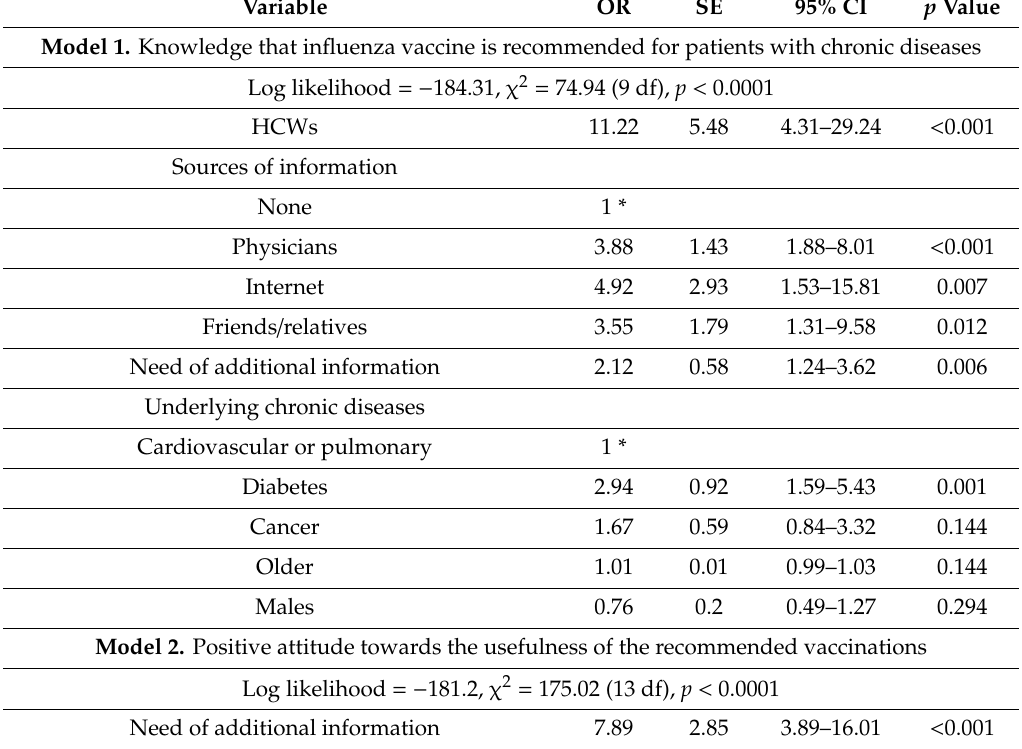
Table 2. Multivariate logistic regression models indicating associations between independent characteristics and the outcomes of